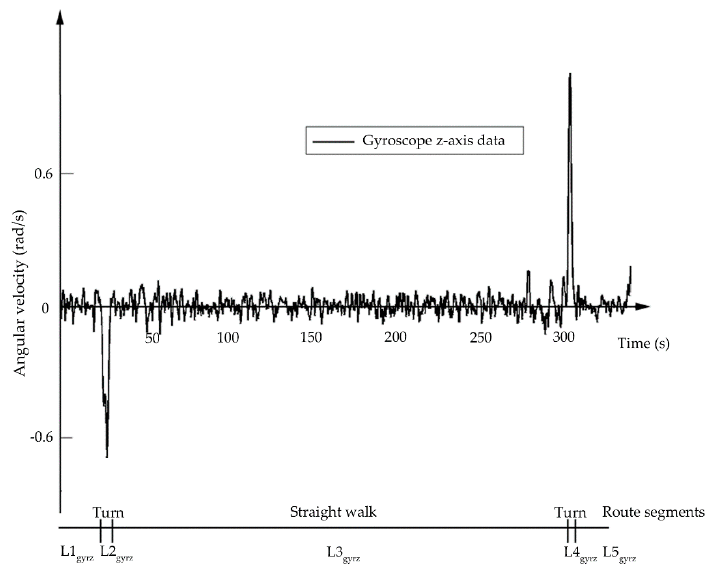
Figure 3. Gyroscope data. Figure 3. Gyroscope